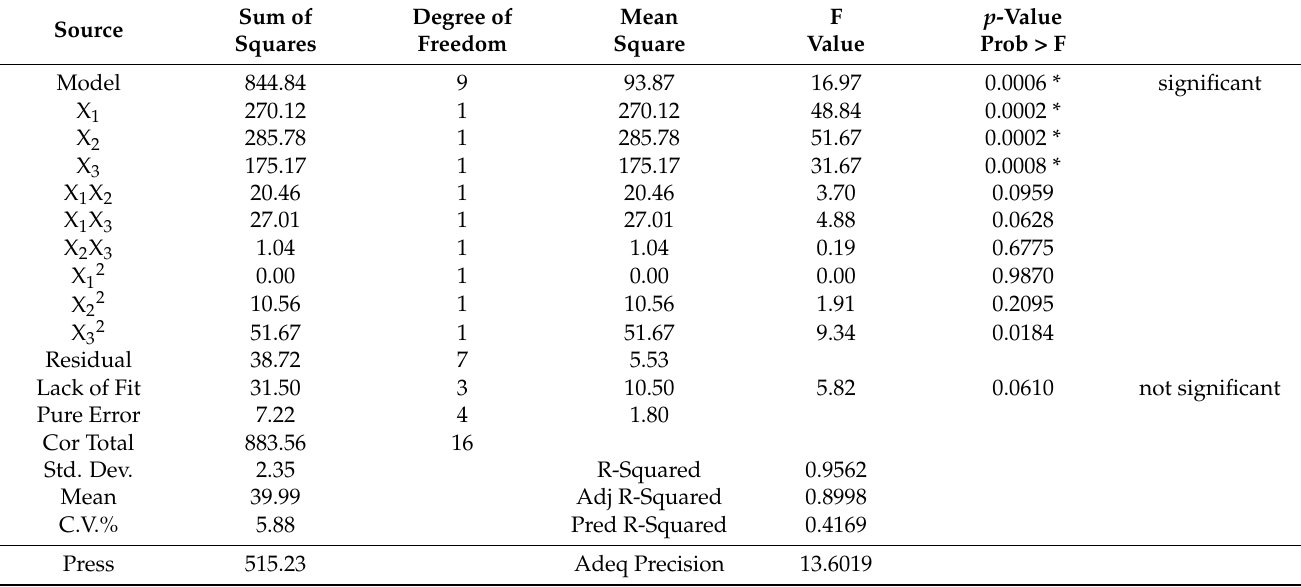
Table 4. ANOVA analysis on asarinin